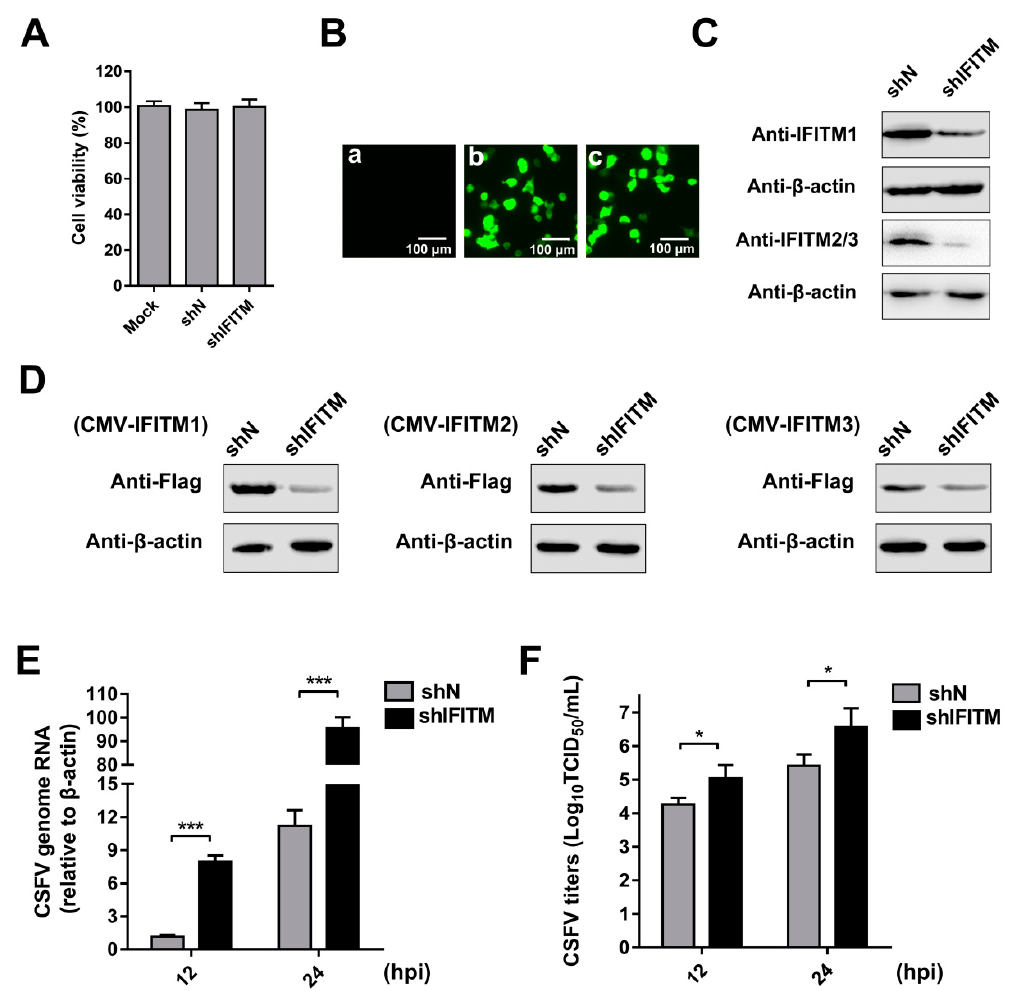
Figure 2. Knockdown of IFITMs mediated by short hairpin RNA (shRNA) enhances CSFV replication. ( A ) Cell viability of stable IFITM-knockdown cell line. ( B ) Confirmation of recombinant IFITM